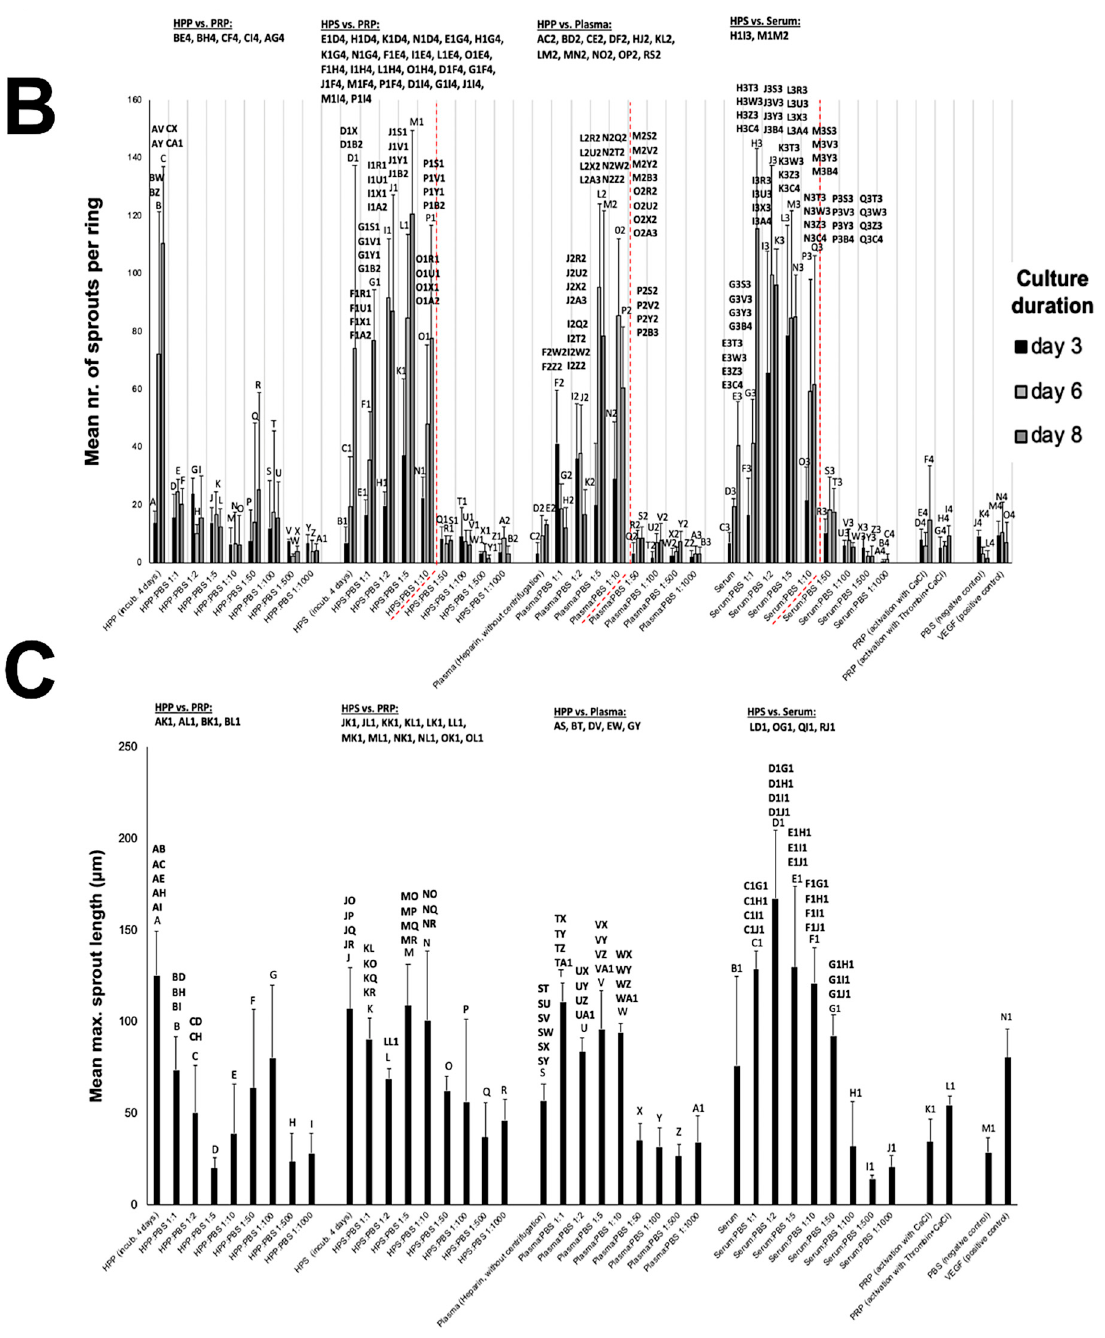
Figure 7. Effect of hypoxia preconditioned secretome dilution on microvessel sprouting in vitro. ( A ) Panel showing representative images of aortic rings, embedded in Matrigel and cultured in the presence of diluted blood-derived secretomes for 3, 6 and 8 days (Bars = 100 µ m). Microvessels sprouting from aortic rings are indicated by black arrows. Enlarged image sections are shown by red insets. ( B ) Plot showing the mean number of sprouts per ring over a culture duration of 3,6 and 8 days ( n = 3). ( C ) Plot showing the mean maximum sprout length after a culture period of 8 days ( n = 3). Red dashed lines on plots and images indicate statistically significant cut-off points of dilution. Capital letter pairs shown directly above histograms indicate intra-condition statistical comparison of corresponding data points, while HPP/HPS vs. Plasma/Serum and HPP/HPS vs. PRP statistical comparisons are shown on the upper part of plot B and C. For all pair comparisons p < 0.05, unless otherwise indicated. Error bars represent s.d.